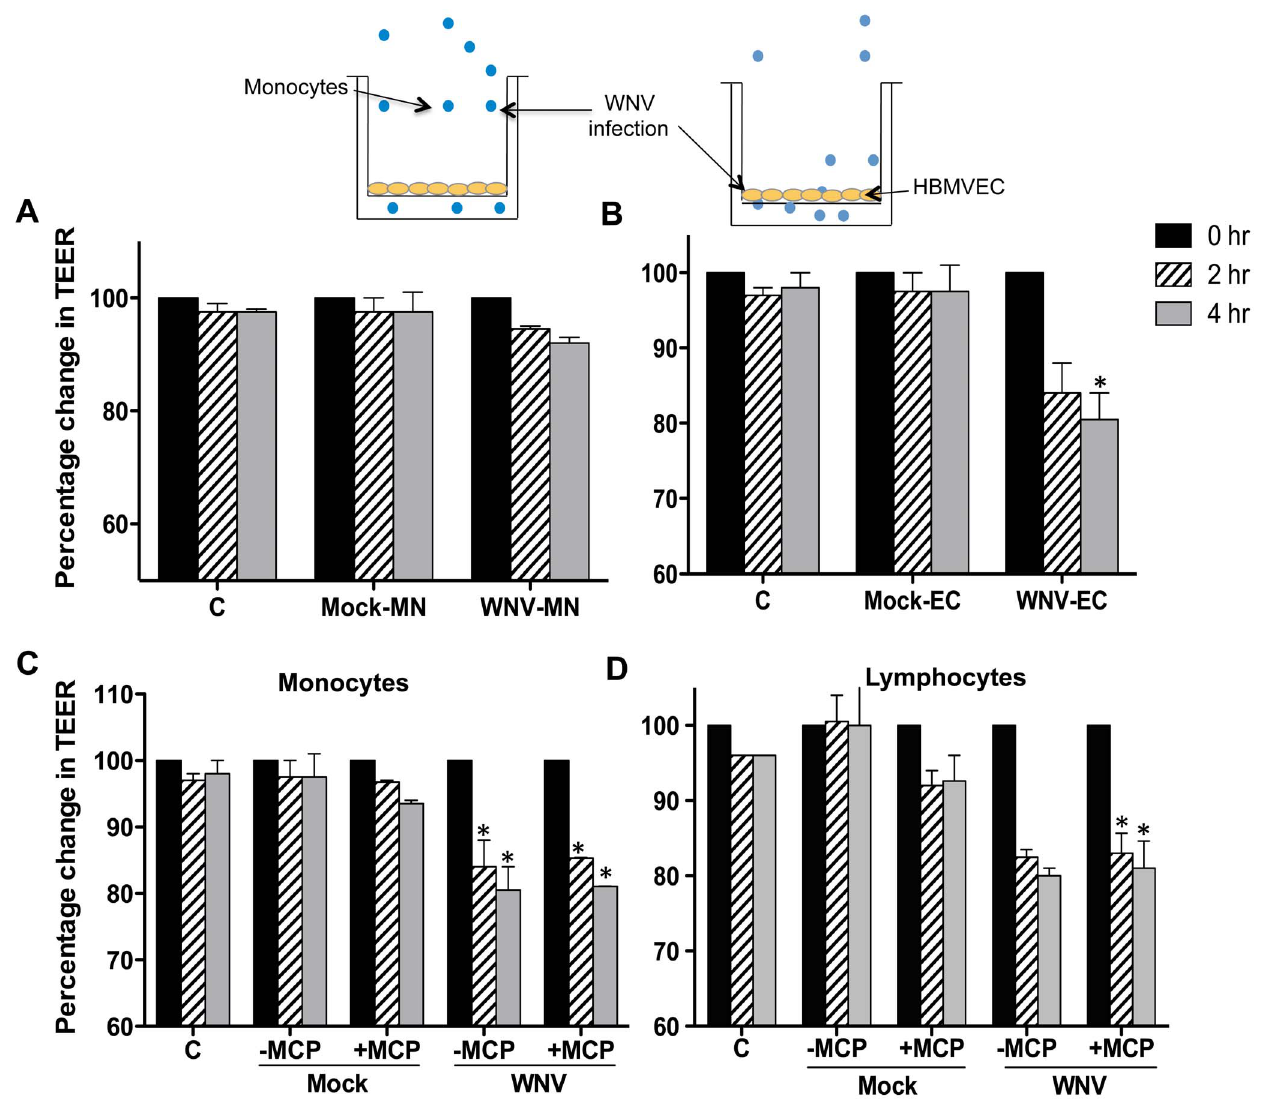
Figure 1. WNV infection of HMBVE cells, but not of leukocytes, mediates the disruption of the invitro BBB model. The effect of leukocyte migration on the permeability of the in vitro BBB model was determined by TEER measurements. ( A) WNV infected monocytes (2.5 x 10 5 ) at 24 hrs after infection were added in the upper compartment of the uninfected BBB model and permeability was measured at 2 and 4 hrs after incubation. ( B ) At 72 hrs after WNV infection of BBB model, transmigration of uninfected monocytes significantly decreased the TEER as compared to control. ( C and D ) A chemotactic gradient was established by the addition of 100 ng/mL recombinant human CCL2 to the lower compartment and uninfected monocytes and lymphocytes were allowed to migrate across infected BBB. Results are the mean of data from two independent experiments in duplicate. *p , 0.05 compared to mock. C, inserts with control HBMVE cells without leukocytes.